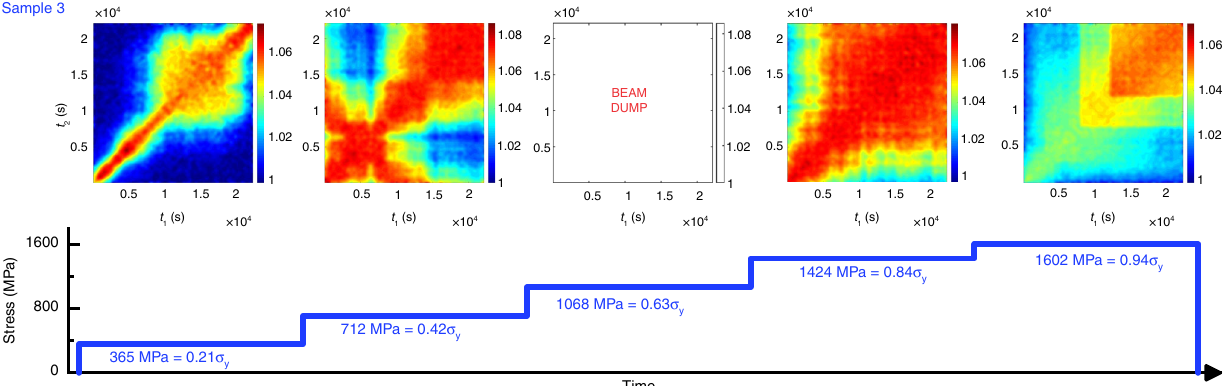
Fig. 5 In situ bending with increasing stress. Two-time correlation functions for Sample 3 as a function of increasing tensile stress. The X-ray beam was lost